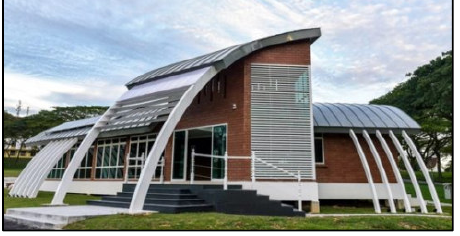
Figure 1 . UTM Eco-home building (www.news.utm.my)